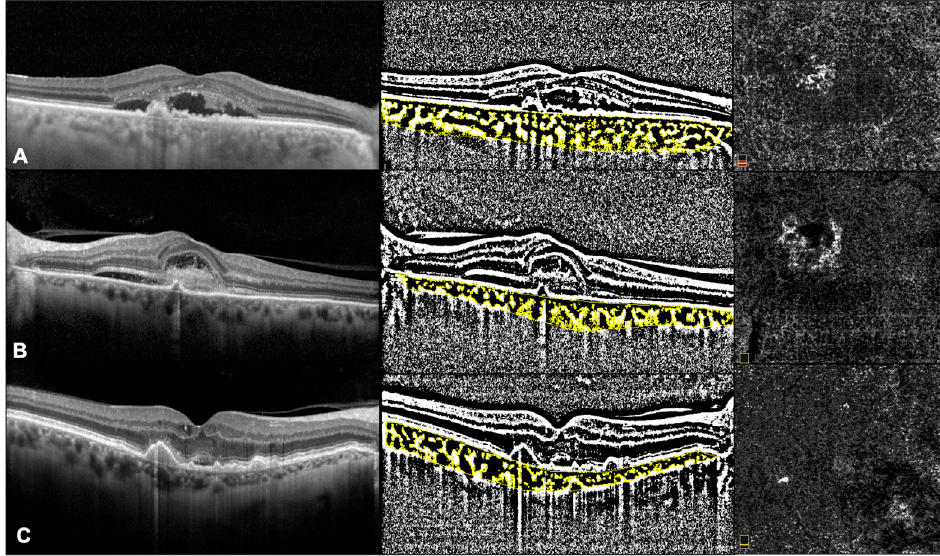
Figure 1. OCT and OCTa images in Type 1 MNV ( A ), type 2 MNV ( B ), and type 3 MNV ( C